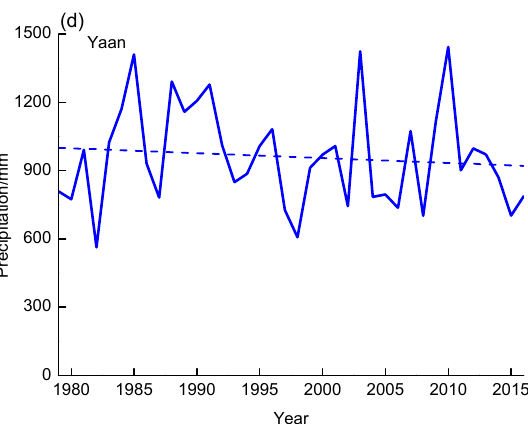
Figure 4. Inter-annual variation of summer precipitation at the three representative stations with large precipitation in the Sichuan Basin from 1979 to 2016. (( a ) the Sichuan Basin, ( b ) Beichuan, ( c ) Wanyuan, and ( d ) Ya’an. The thin lines indicate linear trends.).